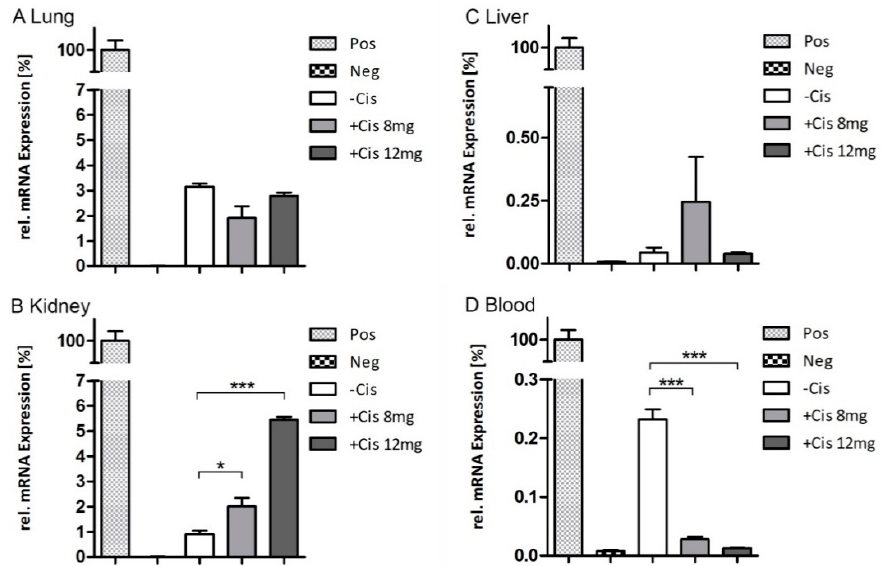
Figure 5. Endpoint qRT-PCR. PCR for luciferase expression was used to detect cells in ( A ) lung, ( B ) kidney, ( C ) liver tissue, and ( D ) blood in control mice and in AKI-induced mice at day 6 after cell injection. RNA from Luc + - and Luc - -mASCs was used as positive (Pos) and negative (Neg) control. * p < 0.05 and *** p < 0.001 vs. control; n = 5 per group.